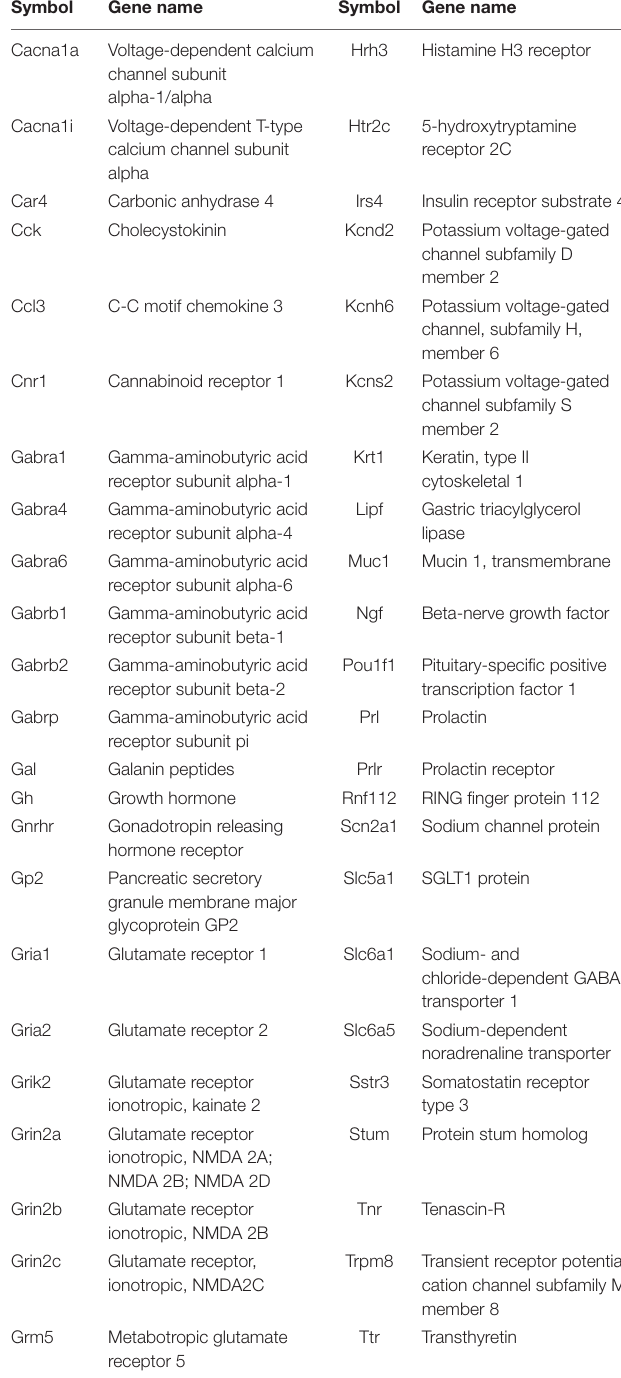
TABLE 2 | Pharos analysis of genes showing greatest up- and down-regulation that can be modulated by small molecules in clinical use.